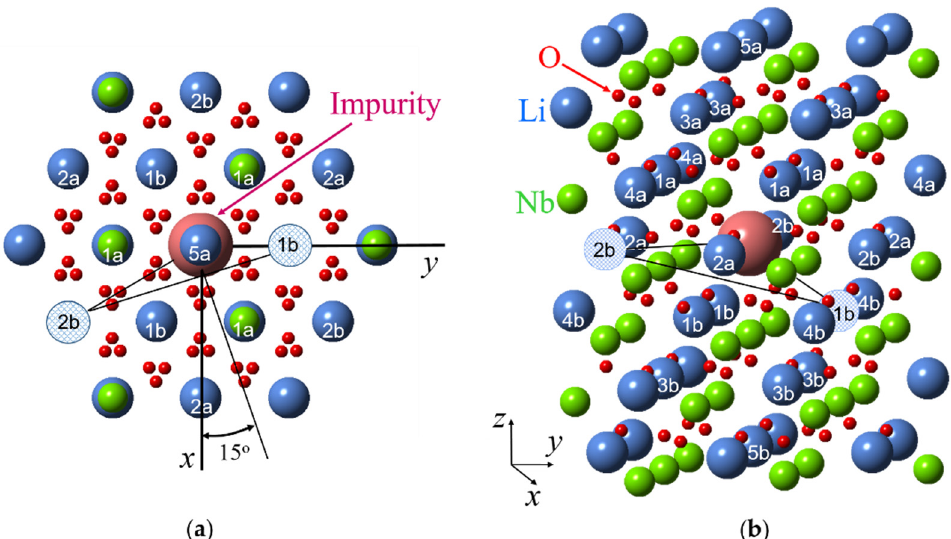
Figure 7. A projection of lithium niobate crystal lattice on xy plane ( a ) and 3D model ( b ) with shell numbers for an impurity substituted for Li + ion (sizes of all ions were artificially changed in order to make clear positions of cation ions). Hatched circles represent two vacancies of Li + ions for Nd 4 center. Table 1. Sites for lithium vacancies, v Li in the surroundings of Me 3+ Li centers in LiNbO 3 .